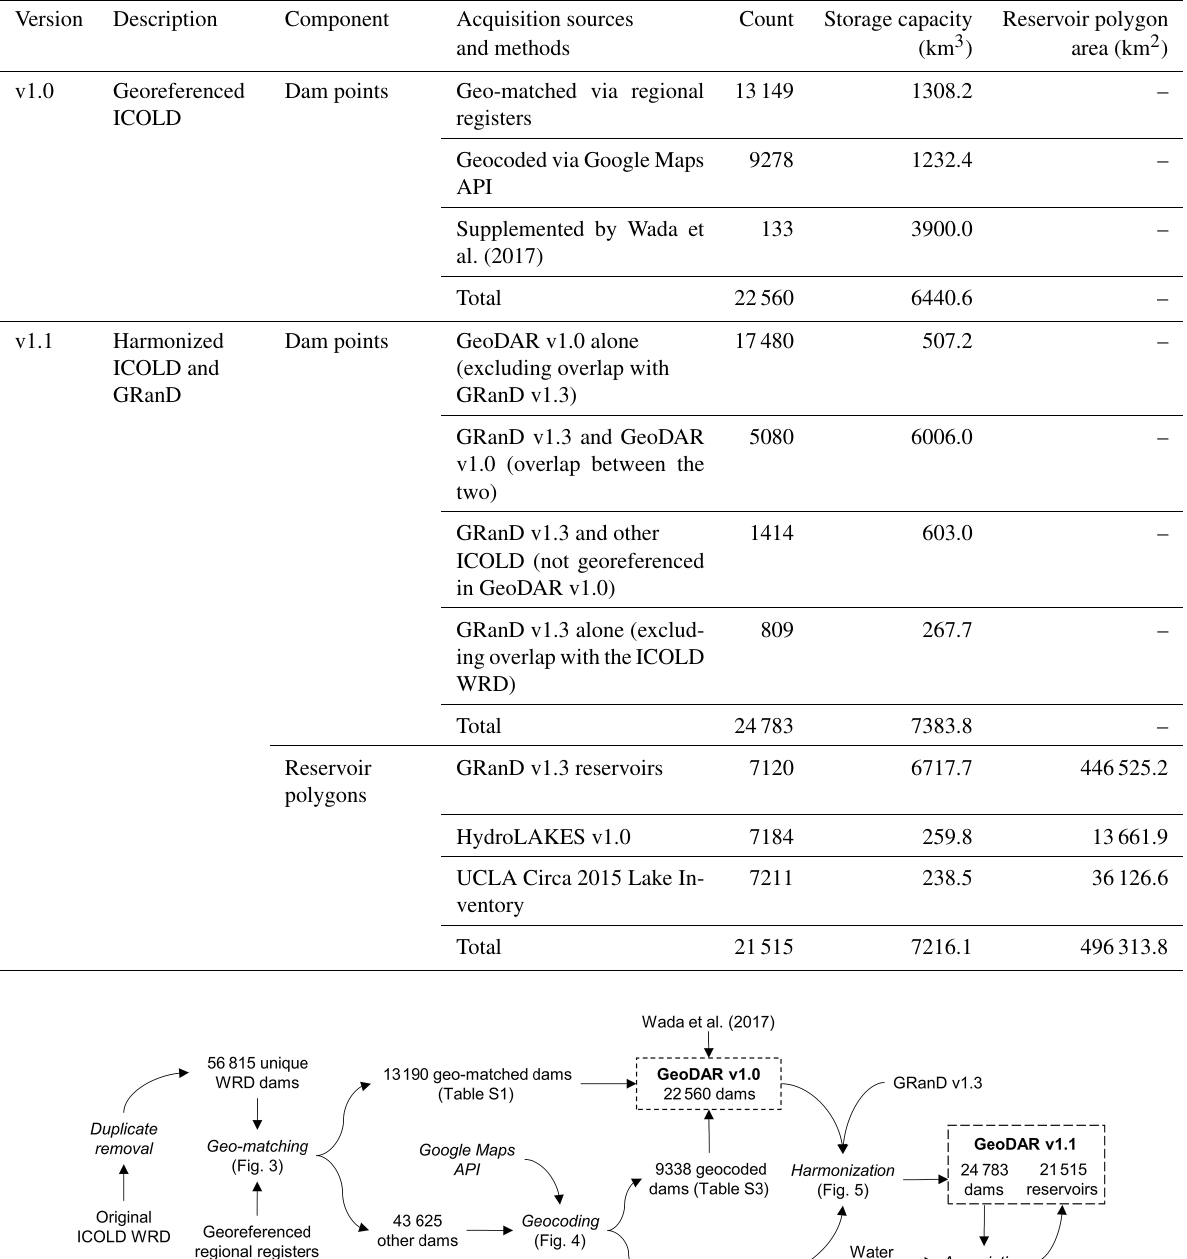
Table 1. GeoDAR product versions and components.